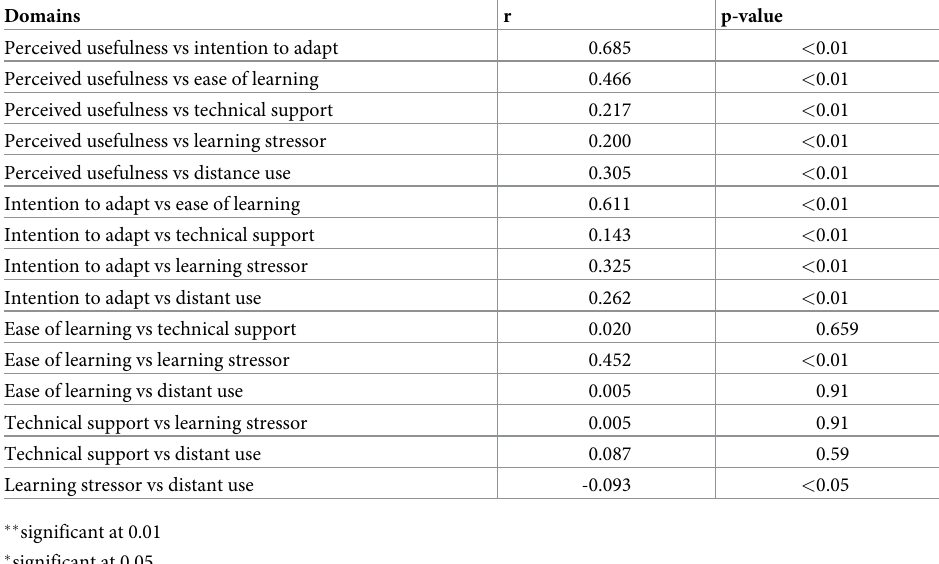
Table 12. Correlation analysis of 6 domains of attitude regarding e-learning (n =